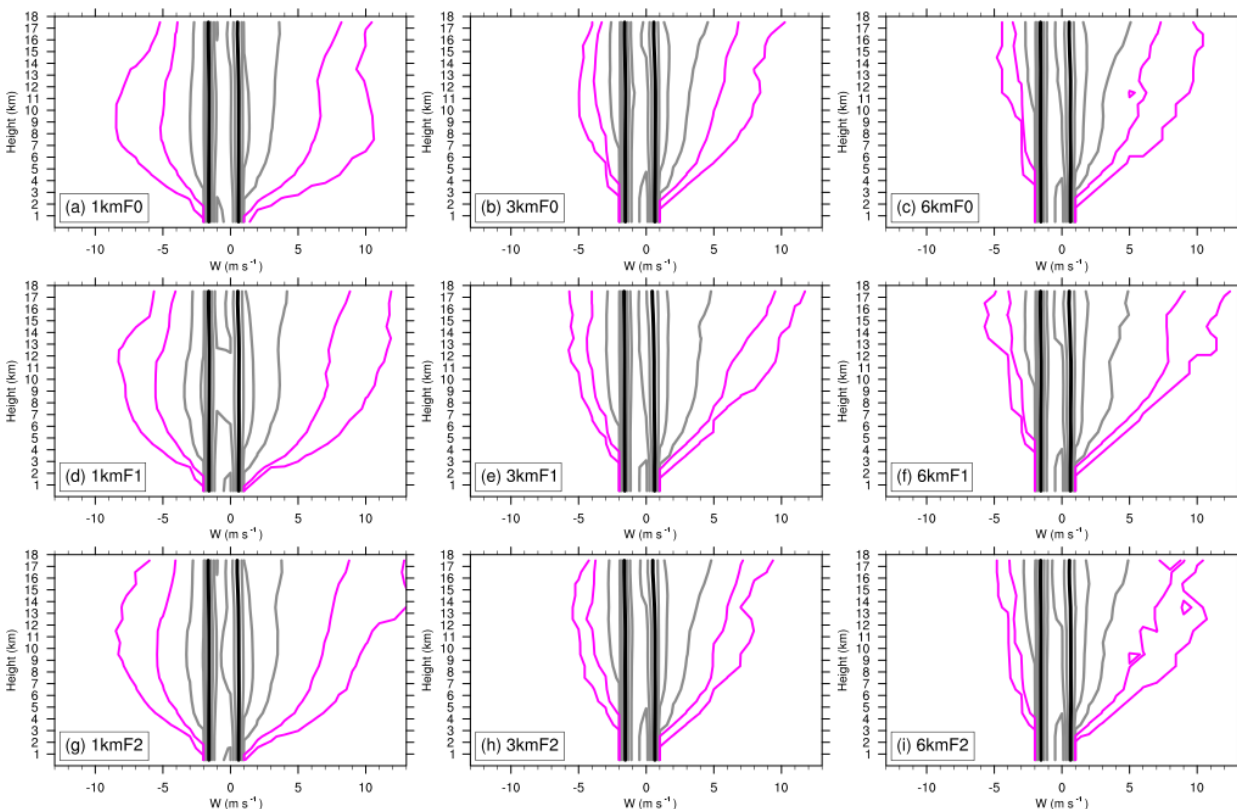
Figure 15. The same as Fig. 14 but for CFADs of simulated vertical velocity. The velocity bin size is 1ms − 1 and the plot is contoured at 0.01%, 0.1%, 1%, 5%, 10%, 20%, 30%, 40%, 50%, and 60% of data per meter per second per kilometer (%m − 1 skm − 1 ), with the 20%m − 1 skm − 1 contour highlighted in black and the lowest two contours displayed in